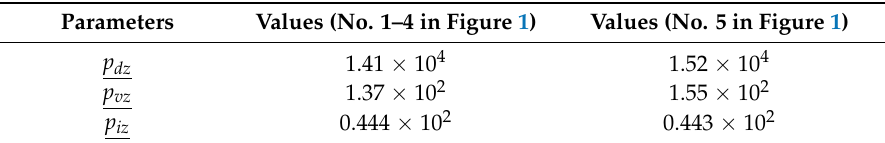
Table 2. The feedback gain of the levitation control system.